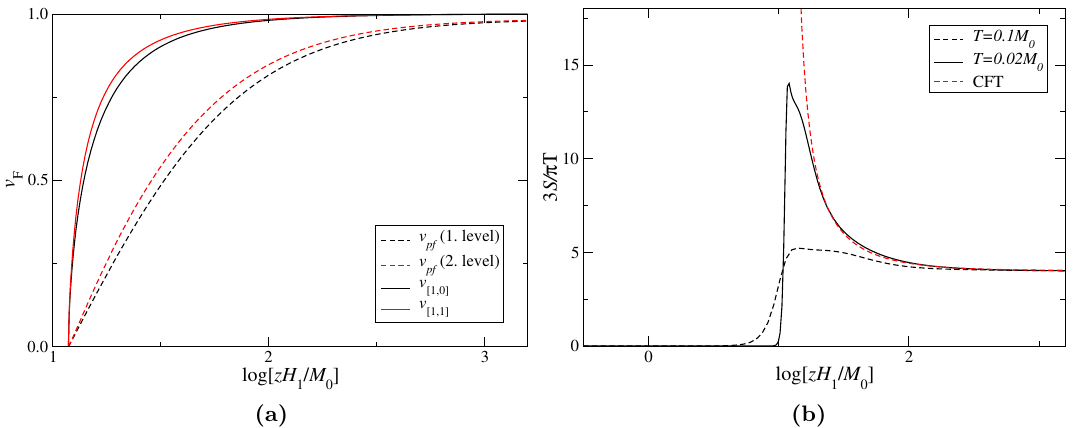
Figure 6 . (a) Fermi velocities as a function of the (cid:12)eld zH 1 =M 0 for p 0 = 2 + 1 = 3 ; zH 2 = (cid:0) 0 : 06 M 0 +0 : 21 zH 1 at zero temperature. For large (cid:12)elds, H 1 > H 1 ;(cid:14) , all Fermi velocities approach 1 leading to the asymptotic result for the low-temperature entropy (2.32). (b) Entropy obtained from numerical solution of the TBA equations (2.12) as a function of the (cid:12)eld zH 2 =M 0 for p 0 = 2 + 1 = 3, (cid:12)xed zH 2 = (cid:0) 0 : 06 M 0 +0 : 21 zH 1 and di(cid:11)erent temperatures. For (cid:12)elds large compared to the kink mass, zH 1 (cid:29) M 0 , the entropy approaches the expected analytical value (2.32) (full red line).